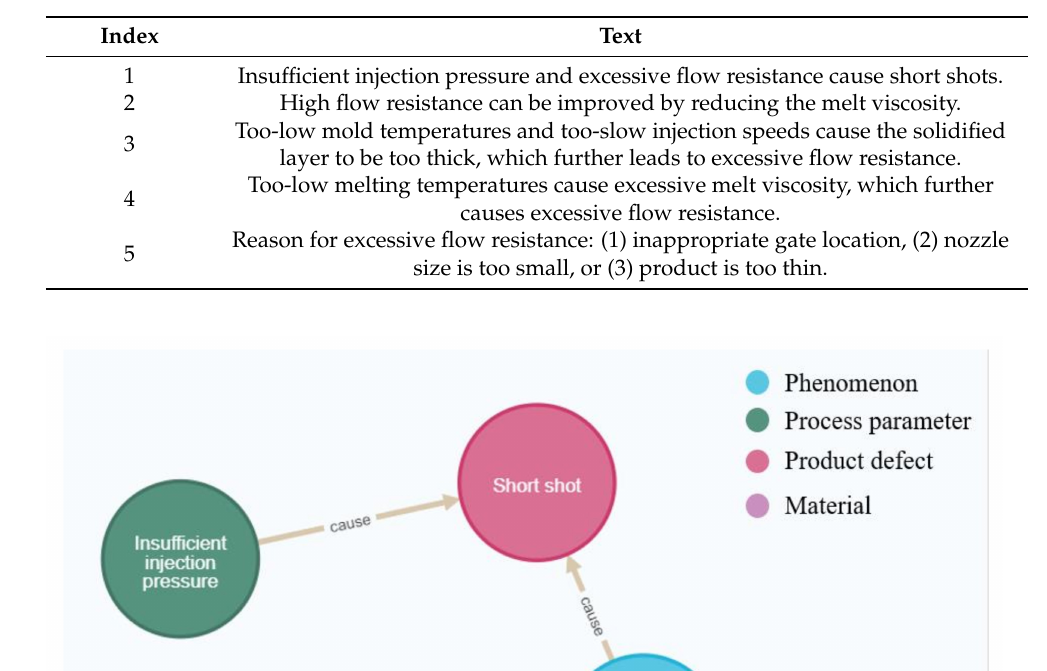
Table 1. Injection molding text data.